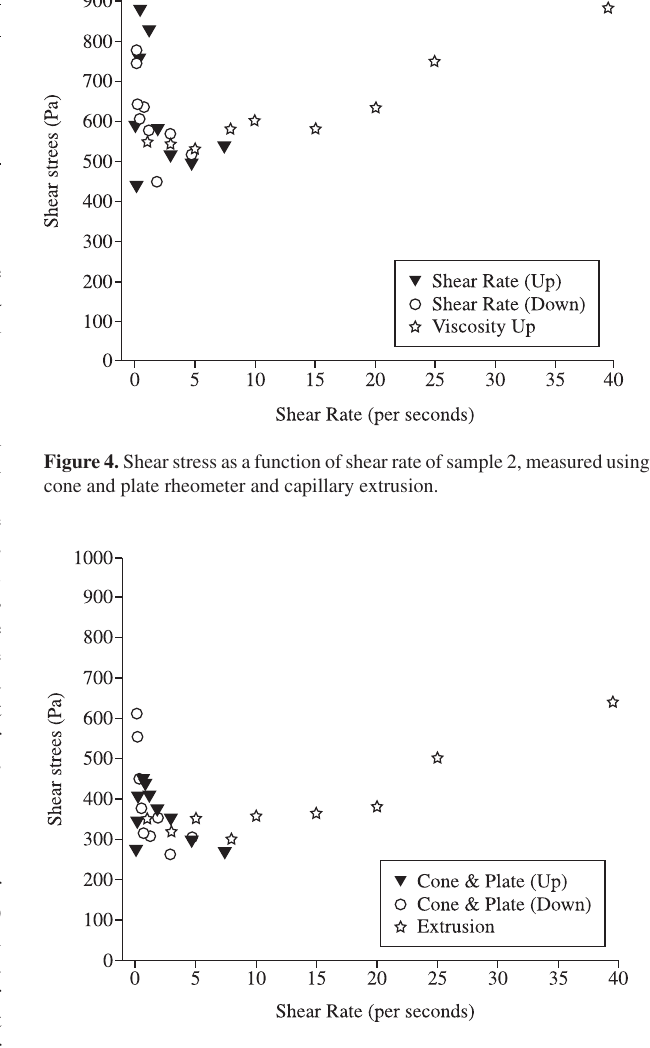
Figure 5. Shear stress as a function of shear rate of sample 3, measured using cone and plate rheometer and capillary extrusion.